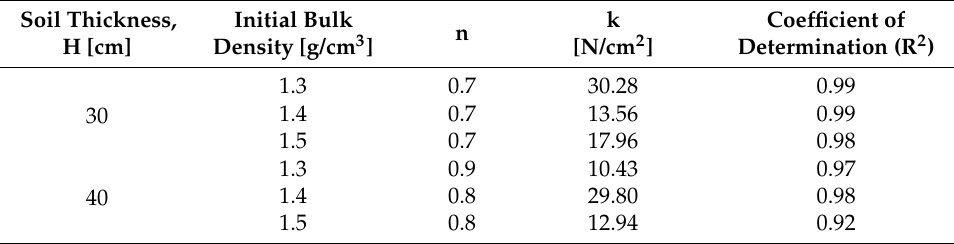
Table 3. Parameters of Equation